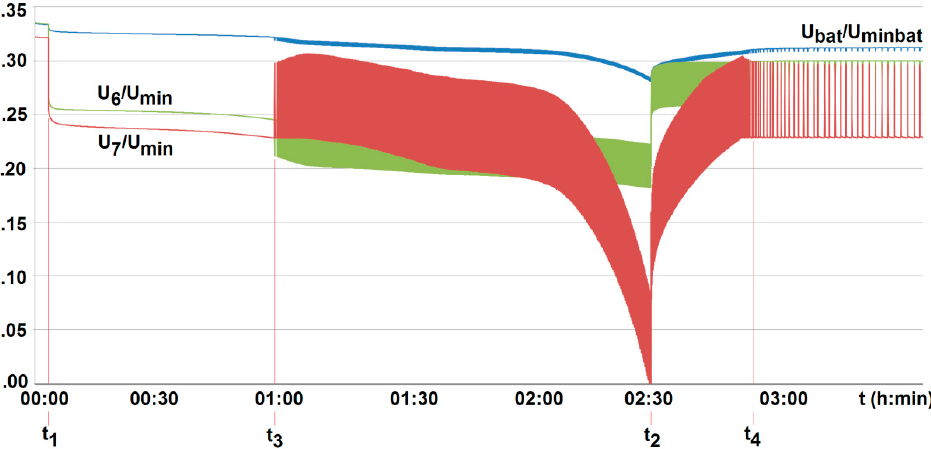
Figure 16. The voltage U 6 /U min and U 7 /U min variation with time for two series-loaded cells (cells no. 6 and no. 7—see Figure 14) of the unburdened battery with the BMS using the battery-to-cell method (room temperature T 0 = 20 °C, free cooling, t 1 , t 2 —moment of switching on and off the load current of 2.5 A, U min —minimum cell voltage equal to 2.5 A, U minbat —minimum battery voltage 20 V, U bat —battery voltage (maximum 29.2 V), t 3 , t 4 —switching on and off the active balancing.